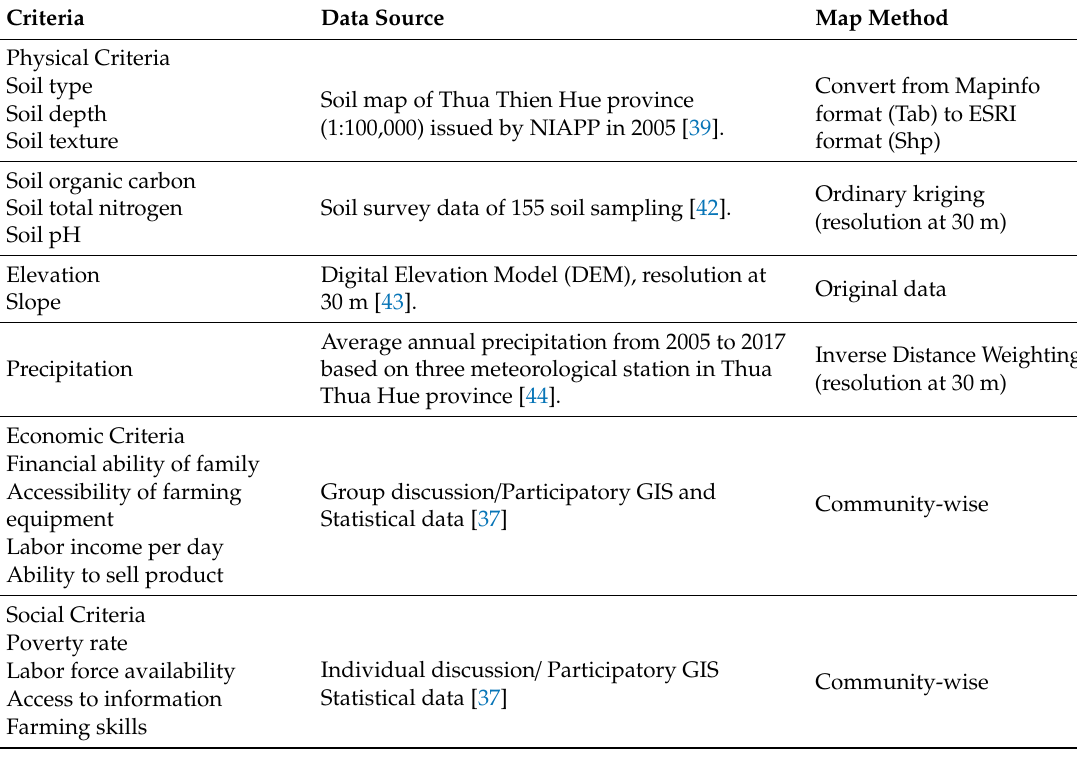
Table 1. List of data sets used in this